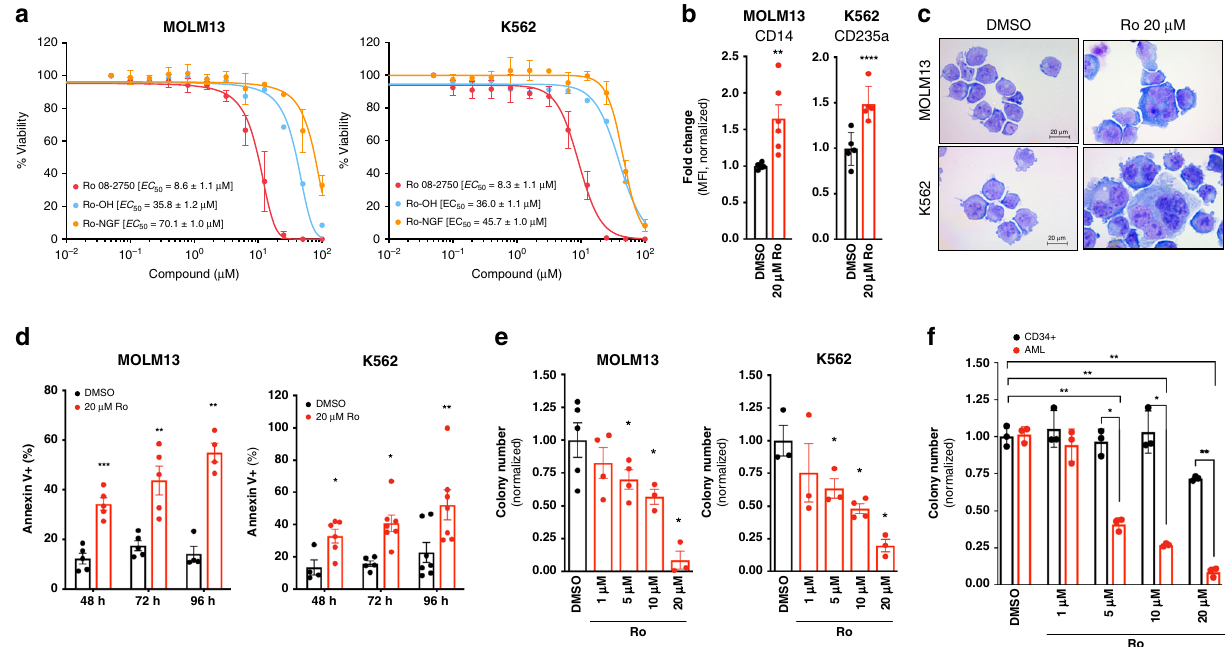
Fig. 4 Ro 08 – 2750 treatment inhibits survival of human AML cell lines and patient cells. a Cytotoxicity assay (Cell-Titer Glo) of Ro, Ro-OH and Ro-NGF in MOLM13 and K562 cells. EC 50 values average of three independent experiments ± s.d. is shown. b Mean Fluorescence Intensity (MFI) fold changes of CD14 (myeloid marker, MOLM13) and GlycA (Glycophorin-A, CD235a; erythroid marker, K562) after 48 h treatment with DMSO (control, black bars), Ro (red bars) at 20 μ M. Data is normalized to DMSO control cells. Representative histograms for each marker are shown in Supplementary Fig. 6a. c Representative immunocytochemistry images of cytospun MOLM13 and K562 cells treated for 48 h with DMSO (control), Ro 20 μ M and stained with Eosin Y and Methylene Blue/ Azure A. Scale, 20 μ m. d Apoptosis analysis by Annexin V + (% population). MOLM13 and K562 were cultured in DMSO ( black bars ) or in the presence of Ro 20 μ M (red bars) for the indicated times and Annexin V positivity and 7AAD was measured. Results represent three independent experiments ± s.d. e CFU assay of MOLM13 and K562 in the presence of Ro at different concentrations (1, 5, 10, and 20 μ M). Data is shown as average colony numbers (normalized to DMSO control) ± s.e.m. of at least three independent experiments. f CFU assay of cord-blood derived CD34 + HSPCs and AML patient BM cells. Data is shown as average colony numbers (normalized to DMSO) ± s.e.m. of three different blood donors for CD34 + and three independent AML patients. Two tailed Paired t -test (DMSO versus Ro treated, unless indicated with lines); * p < 0.05; ** p < 0.01; *** p < 0.005, **** p < 0.001. Source data are provided as a Source Data fi